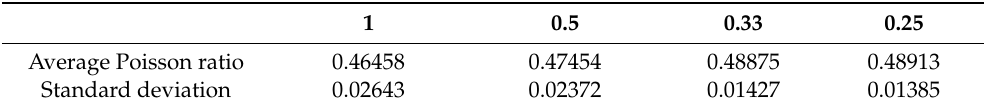
Table 10. Comparison of average Poisson ratios in different shape factors (1–0.25) obtained from the minimum RMSE curve fit and its standard deviations.